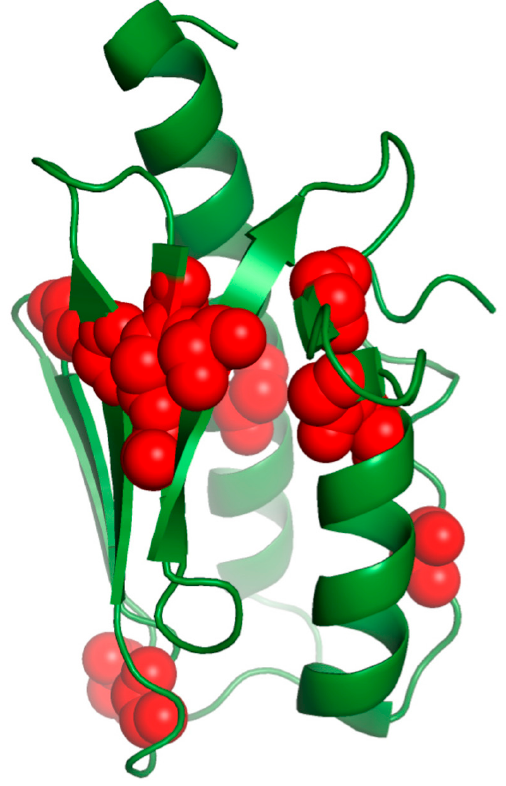
Figure 4. Frataxin residues substituted in FRDA mutants are colored in red.